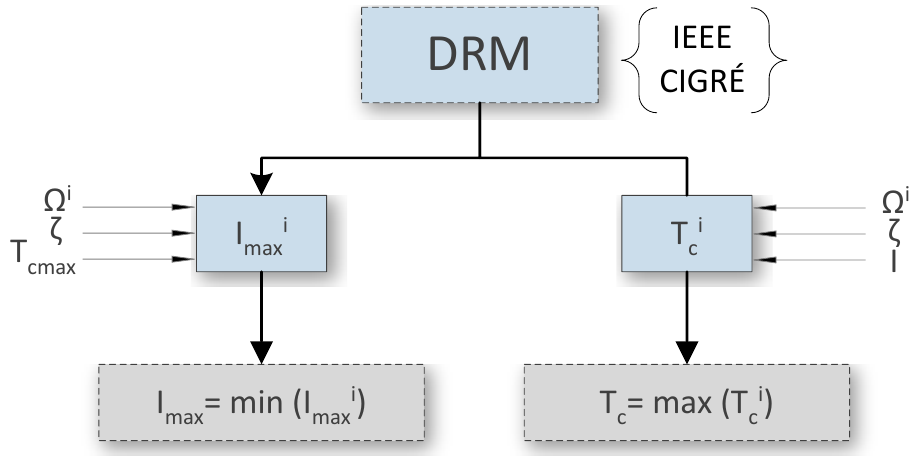
Figure 1. Dynamic Rating Management (DRM) system